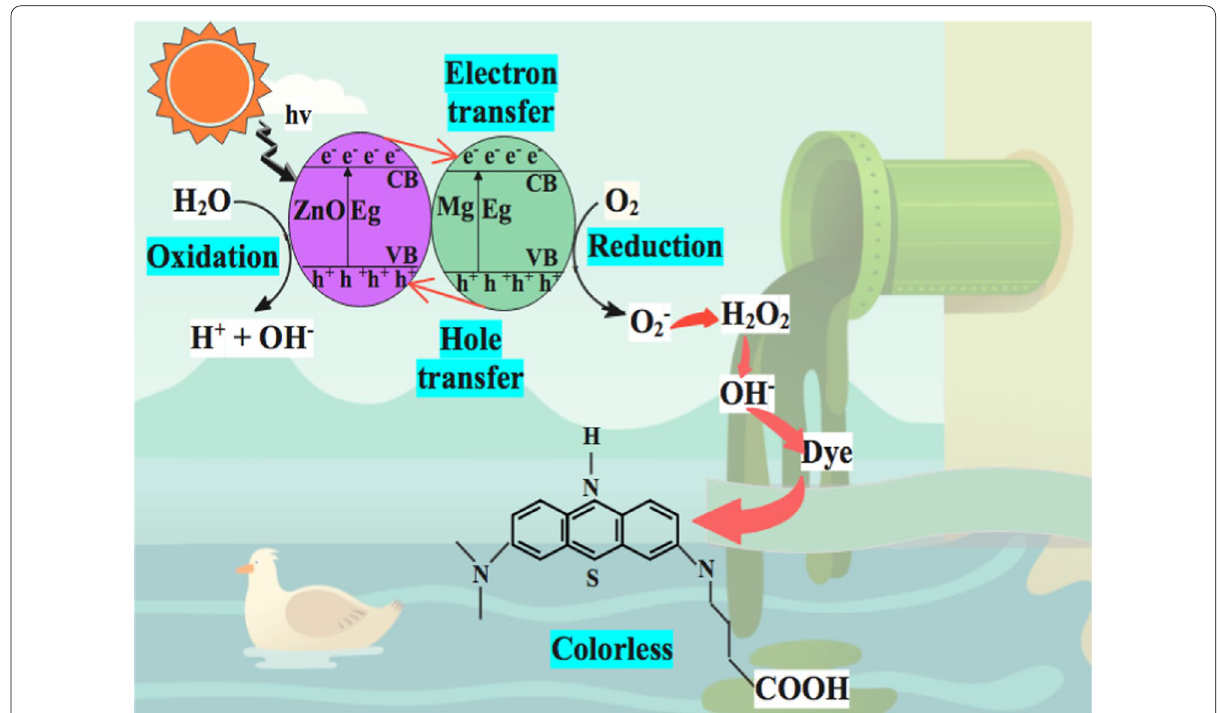
Fig. 6 Schematic illustration of photocatalysis mechanism of Mg‑doped ZnO